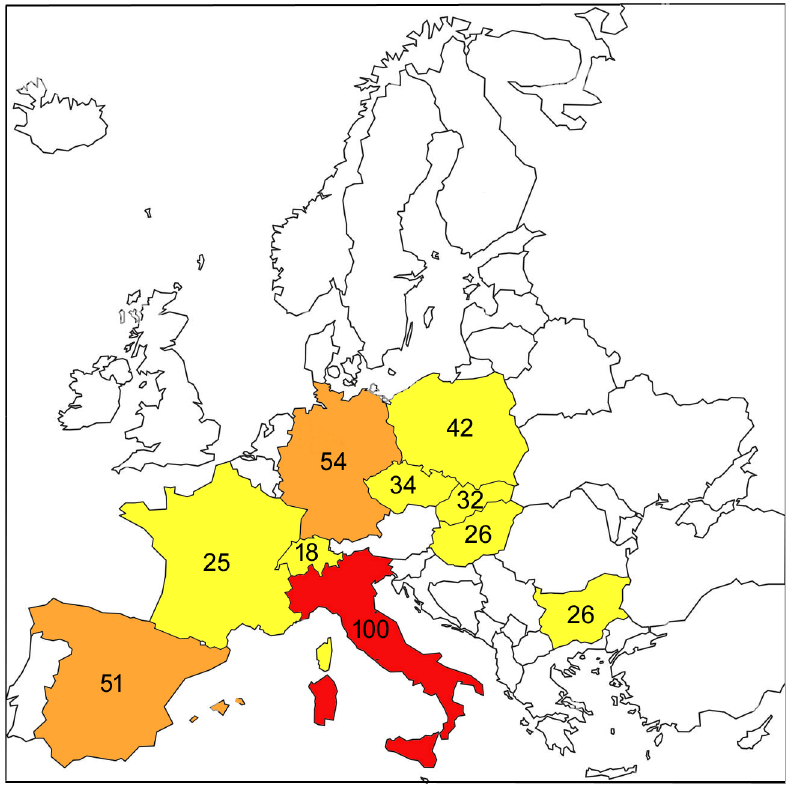
Figure 1. Top 10 countries by the number of sources on dormice in the diets of predators found.